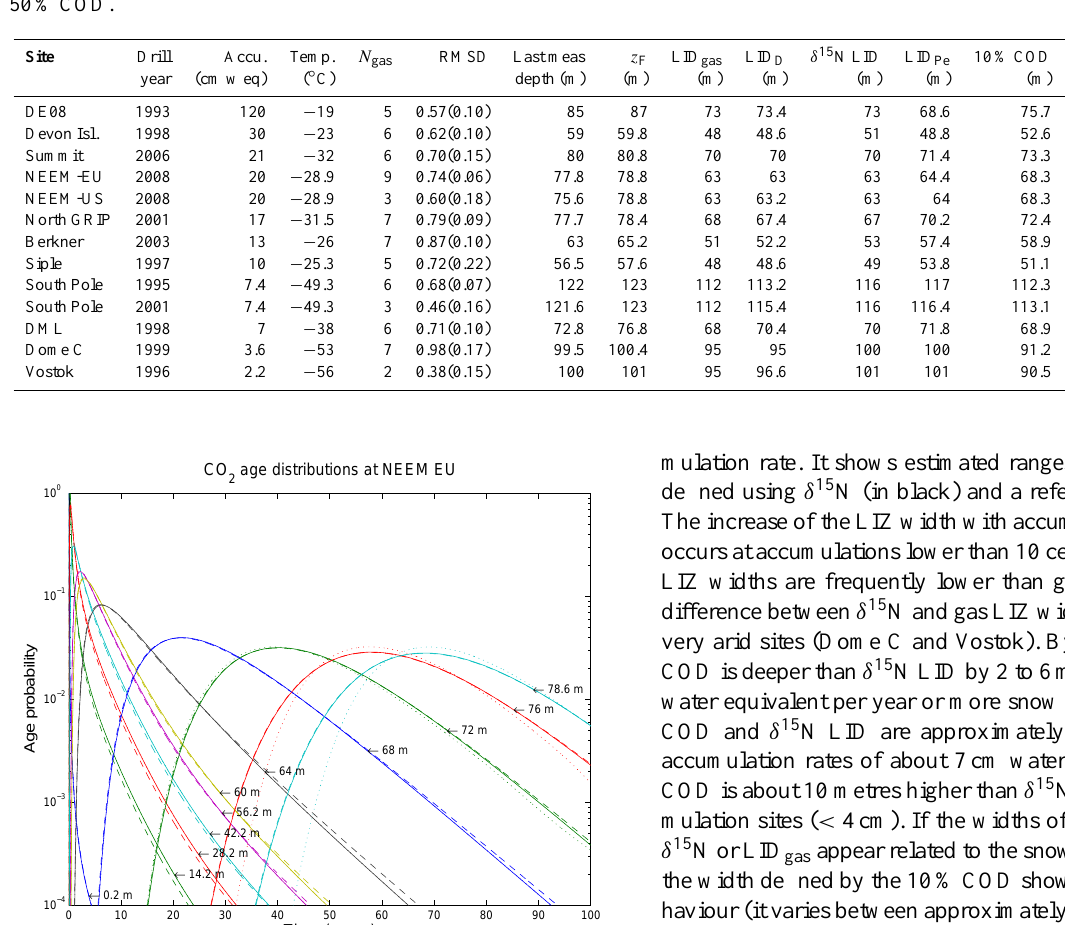
Table 2. Physical characteristics of modelled firn air pumping sites. Devon Island, Summit, North Grip and NEEM are Arctic sites; other sites are Antarctic sites (DML stands for Dronning Maud Land). Major climatic parameters: snow accumulation rate (in centimetres water equivalent per year) and temperature are indicated in columns three and four. Columns 5 to 7 provide quality indicators for the diffusivity profiles: N gas is the number of reference gases used for constraining diffusivity, the RMSD column provides the root-mean-square deviation between model results and data for the reference gases (the number between parentheses is the difference between the maximum and minimum RMSD calculated with N gas − 1). Columns 8 to 14 provide indicators of the top and bottom heights of the LIZ: the last sampling (or measurement) depth, the model’s full COD (open porosity is zero, corresponding to z F in Eq. 4), LID gas is the approximate depth at which a slope break is observed in the CO 2 and/or CH 4 depth profile (see e.g., Fig. 1), LID D is the depth at which D CO LID is the depth at which δ 15 N fractionation stops, LID Pe is the depth at which the P´eclet number becomes larger than 5, 10% COD and 50% COD are the depths at which the closed/total porosity ratios are 10% and 50%, respectively. The last column provides the mean age at 50% COD.